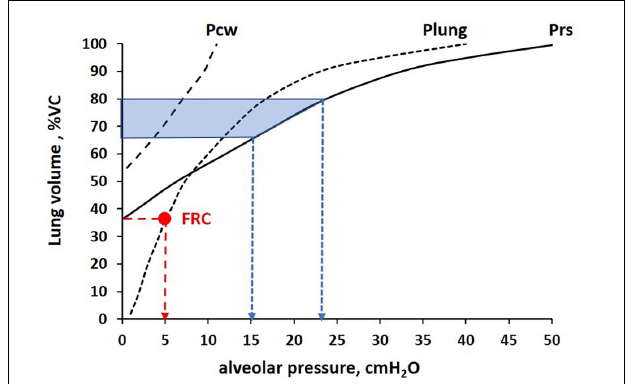
FIGURE 6 | Volume-pressure curve of the lung, chest wall, and total respiratory system (Plung, Pcw, Prs, respectively) to identify the relative lung distention at functional residual capacity (FRC) (Palv = 5 cmH 2 O, red arrow) and completion of the alveolar unfolding process occurring in the range Palv 15–25 cmH 2 O (blue arrows), corresponding to ∼ 65–80% Vital Capacity (VC, shaded